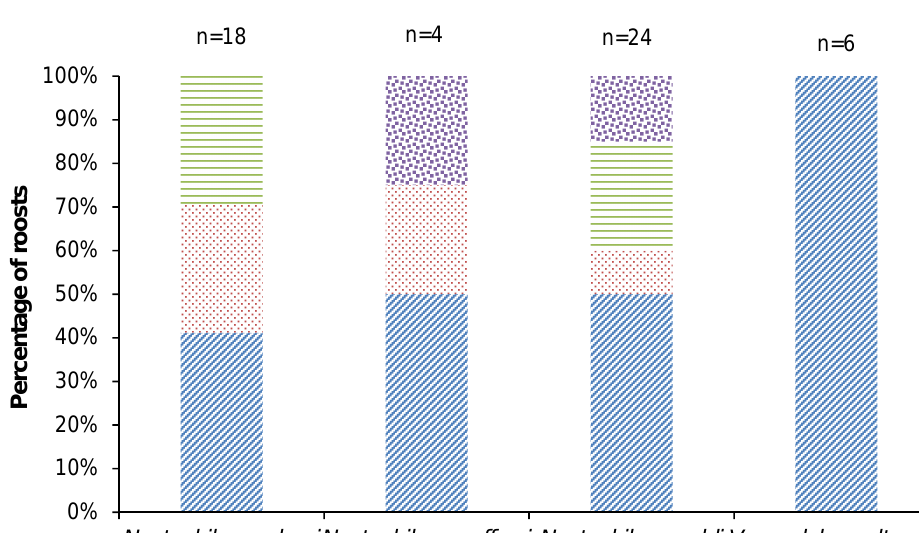
Figure 3. Percentage of roosts of each species that were located in a hollow, fissure, under bark and hollow/fissure (classification uncertain) (2016 and 2017).